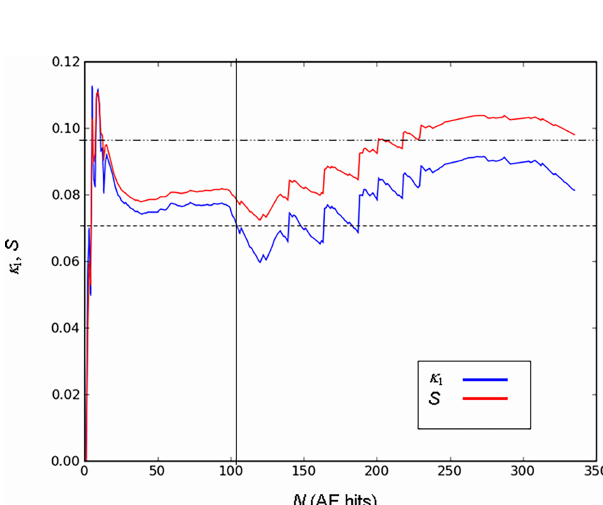
Figure 6. Map showing the epicenter of the magnitude 3 earthquake that occurred on 31 December 2015 and the related preparation zone encircling the monitoring site in